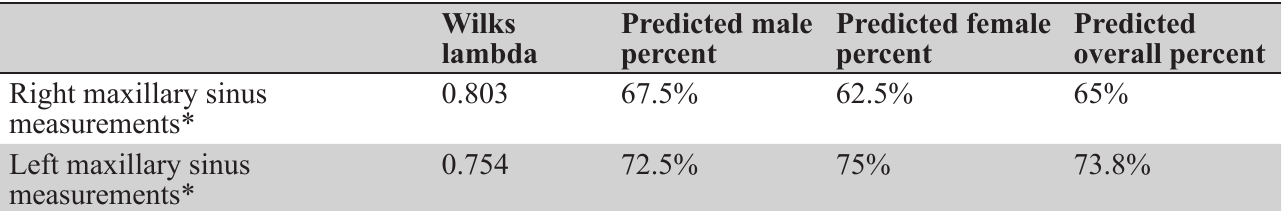
Right maxillary sinus width Left maxillary sinus width Right maxillary sinus height Right maxillary sinus volume Table 4. Discriminant analysis using alone right or left maxillary sinus measurements to distinguish between males and females